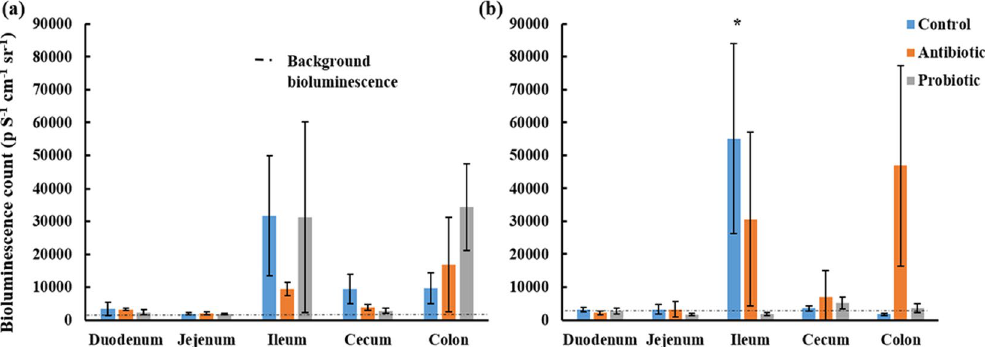
Figure 2. Bioluminescence counts (p S − 1 cm − 1 sr − 1 ) for the different gastro-intestinal compartments (duodenum, jejunum, ileum, cecum and colon) of broilers from the different treatment groups (multi-strain probiotic, antibiotic combination and control) at 2 and 3.5 h after administration of L . monocytogenes EGDe. * Indicates significant differences (p < 0.05; Kruskal-Wallis nonparametric